Question: Sum up the contents of this chart in one sentence.
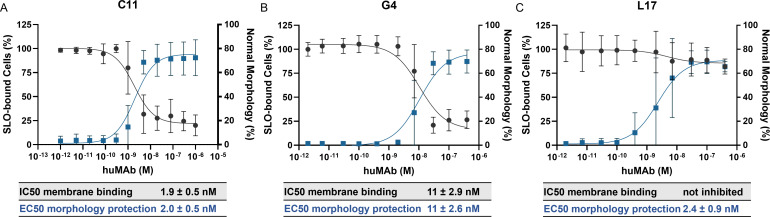
Answer: HuMAbs neutralize SLO by distinct mechanisms of action. Fluorescently labeled SLO was incubated with increasing concentrations of C11 ( A ), G4 ( B ), or L17 ( C ), and added to A549 cells. The percentage of SLO + A549 cells (black circles) and the percentage of cells with normal FSC/SSC morphology (blue squares) were determined by flow cytometry and plotted as a function of huMAb concentration. 7-AAD staining confirmed that > 90% of events in the normal-morphology gate were membrane-intact, and SLO + events were predominantly 7-AAD + at the time of acquisition. Symbols represent the mean ± SD from independent experiments (C11, N = 6; G4 and L17, N = 5). Solid lines indicate nonlinear regression fits used to calculate IC50 values. IC50 values shown below each graph correspond to protection from epithelial cell morphology and inhibition of SLO membrane binding of A549 cells.